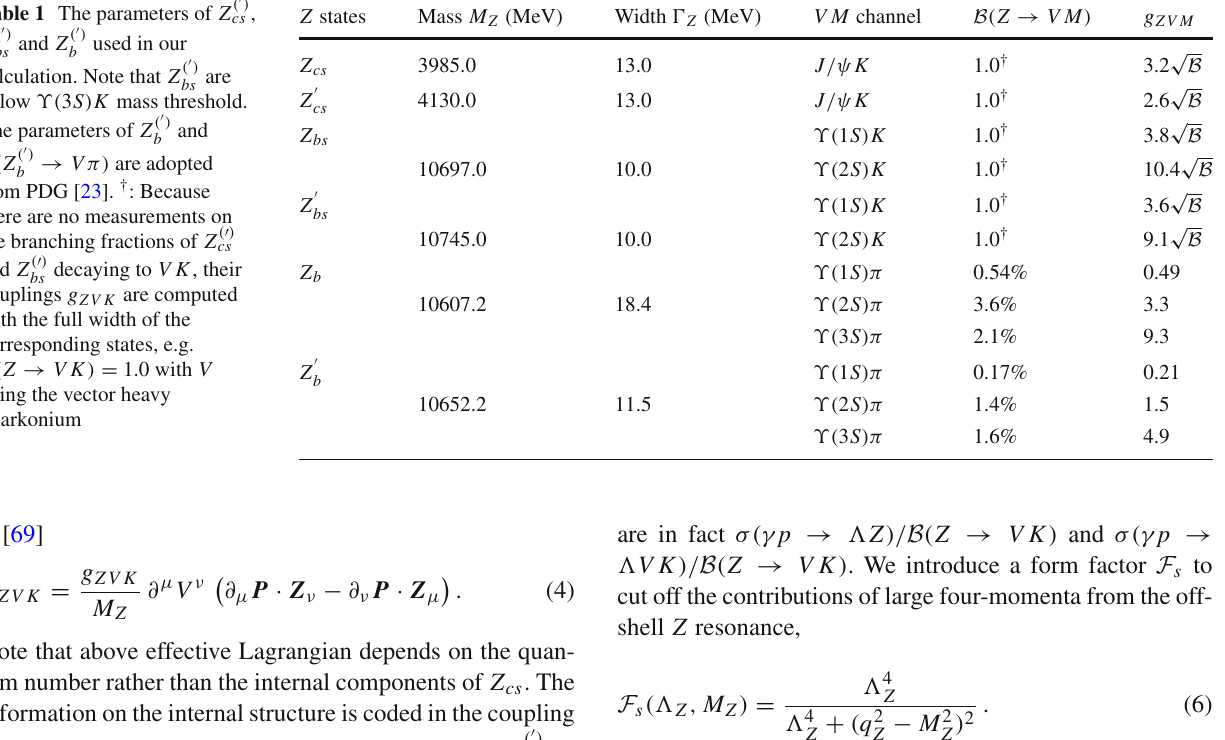
Table 1 The parameters of Z ( (cid:3) ) ( (cid:3) ) Z ( and Z used in our bs b calculation. Note that Z below ϒ( 3 S ) K mass